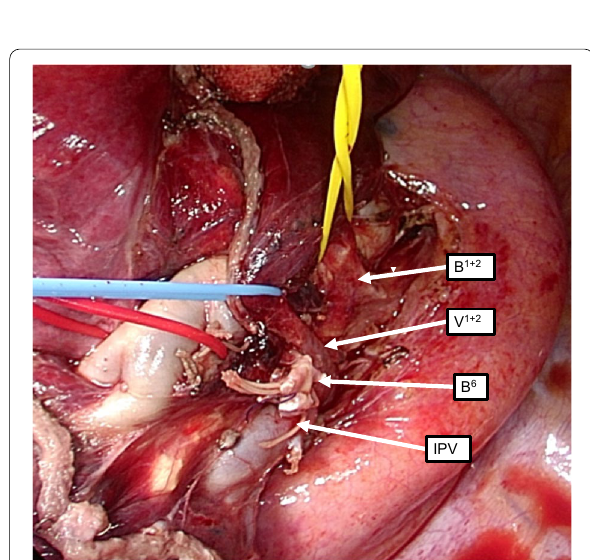
Fig. 3 Thoracoscopic view. Intraoperative findings after segmentectomy. IPV inferior pulmonary